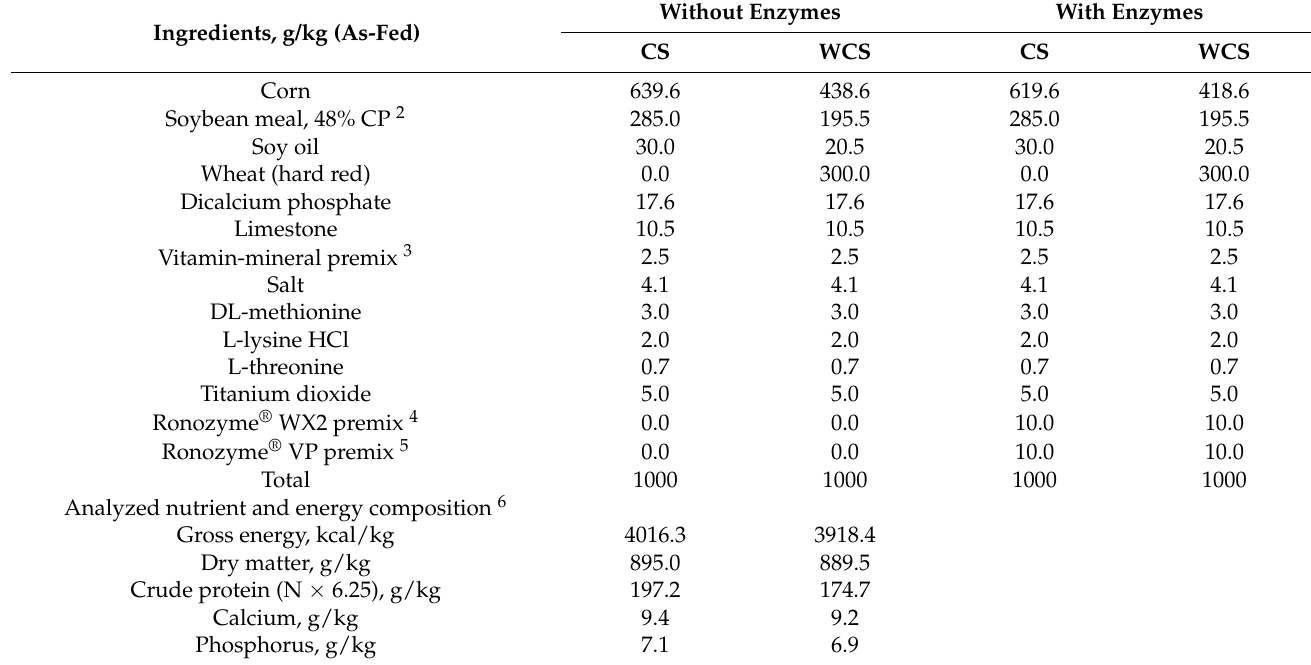
Table 1. Ingredient composition and analyzed dry matter, gross energy, and crude protein values of the experimental diets 1 . Without Ingredients, g/kg (As-Fed)